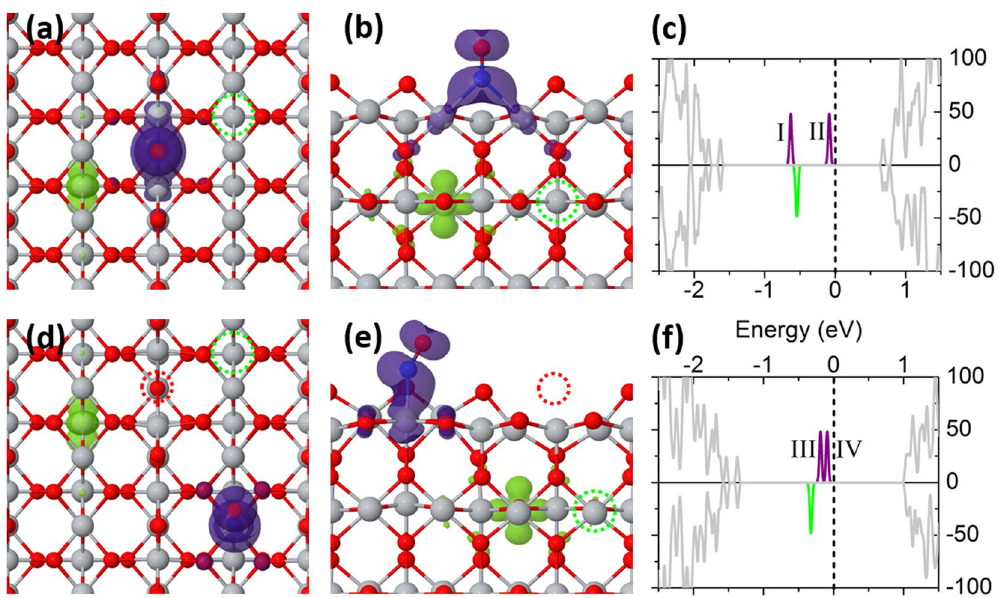
Figure 2. Structure, charge distribution of band-gap states (purple and green isosurfaces in the left and middle panels) and the corresponding density of states of NO-adsorbed TiO 2 (110) surfaces (in the right panel) for different NO adsorption configurations: ( a–c ) NO adsorbed at Vo; ( d–f ) NO adsorbed on Ti 5c of reduced surface with Vo (see the dashed red circles). Left panel: top view; middle panel: side view. For the DOS given in the right panel, the dashed vertical line denotes the Fermi level. The Ti:d-NO:p hybridized states near the Fermi level are shown by the purple peaks, and the spin-down gap state in green represents the polaron in the subsurface. The colorized states situated in the band gap are all rescaled by a factor of 2 for